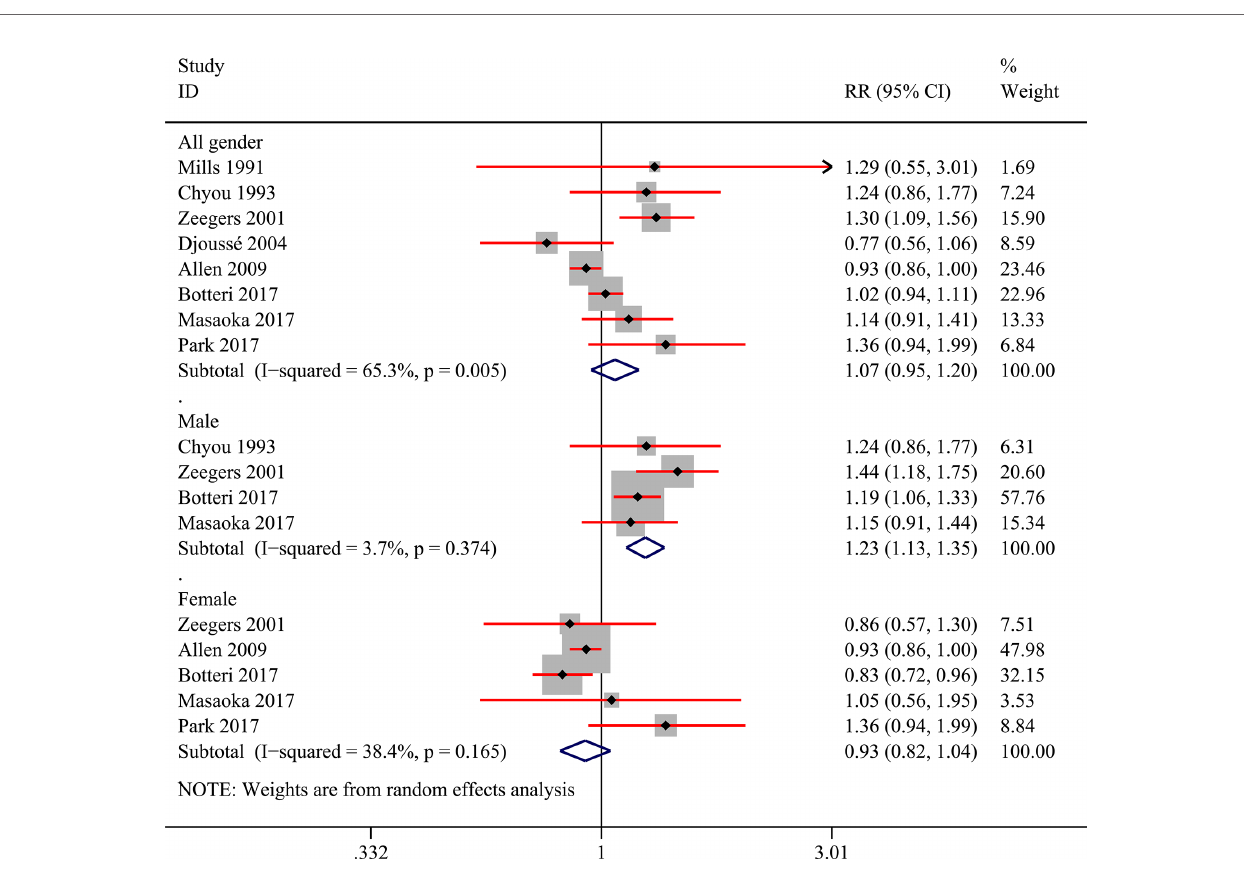
FIGURE 2 | Forest plot of relative risk (RR) of bladder cancer for alcohol consumption (Any versus none) in the entire population and different gender